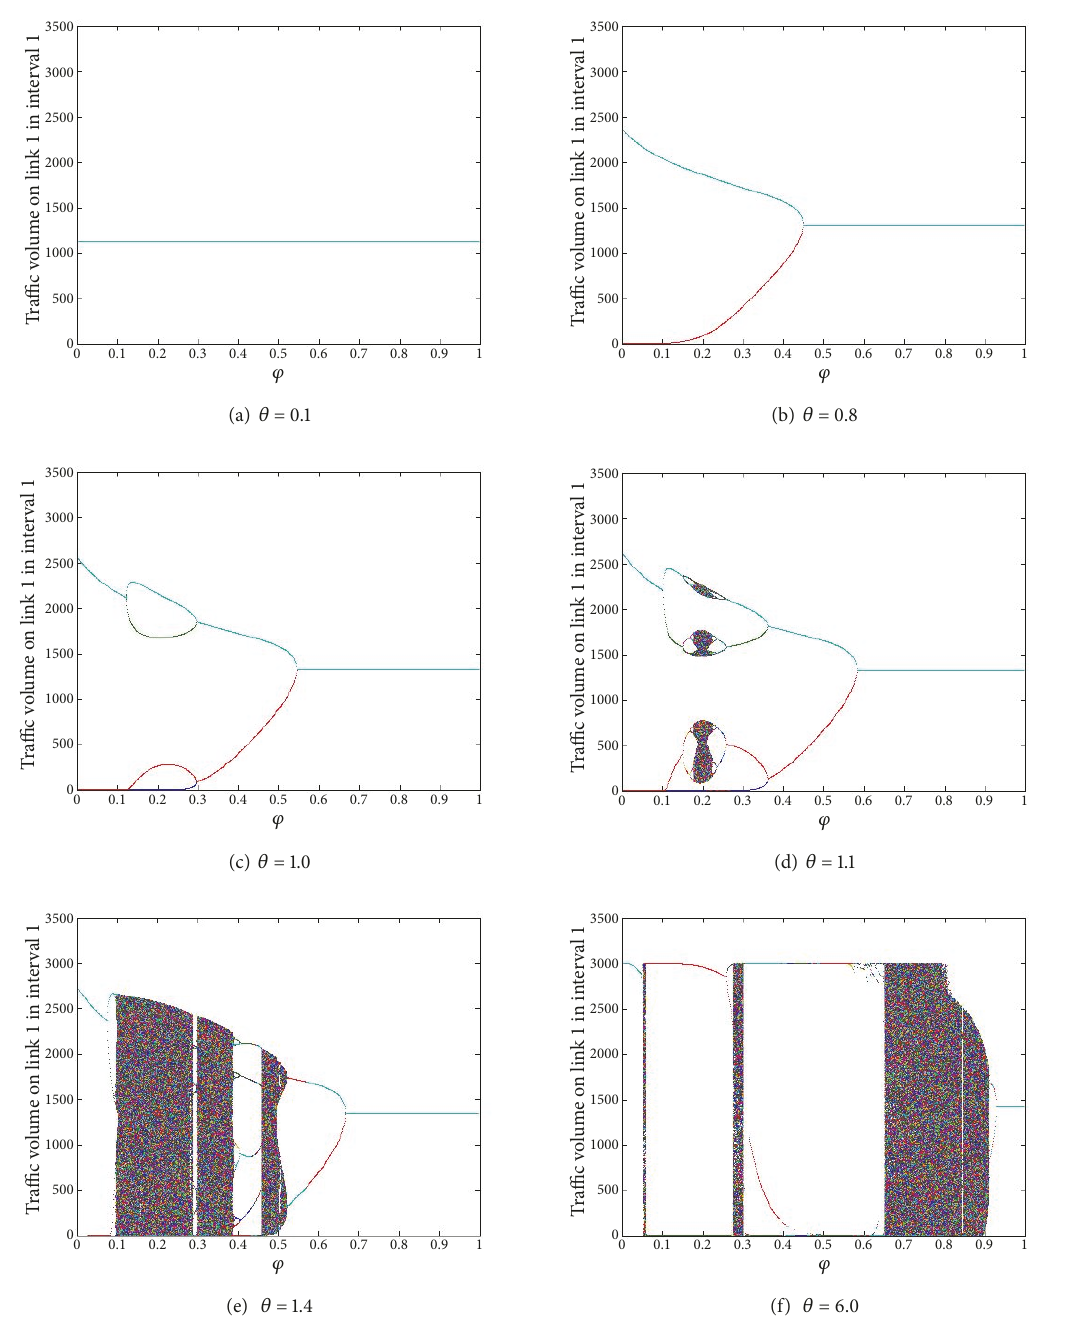
Figure 3: Flow bifurcation diagram with 𝜑 for 𝛼 = 1, 𝜆 = 0.4 for different 𝜃